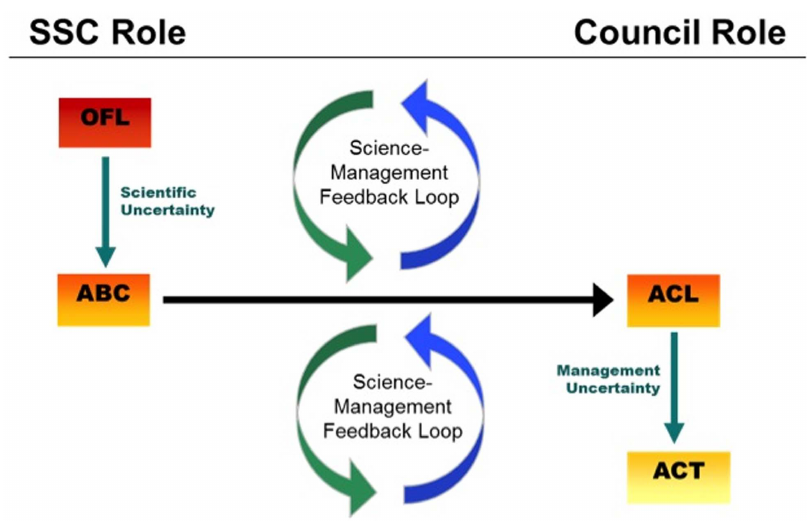
Figure 4. The annual catch limit (ACL) framework, describing how the acceptable biological catch level (ABC) is reduced from the overfishing limit (OFL) based on scientific uncertainty in the estimate of OFL, how the ACL can be set at or below ABC, and how an annual catch target (ACT) can be set below the ACL to account for management uncertainty. The Scientific and Statistical Committee of a Regional Fishery Management Council sets an OFL and ABC, while the Regional Fishery Management Council sets the ACL and ACT; each decision is based on a science-management feedback loop.